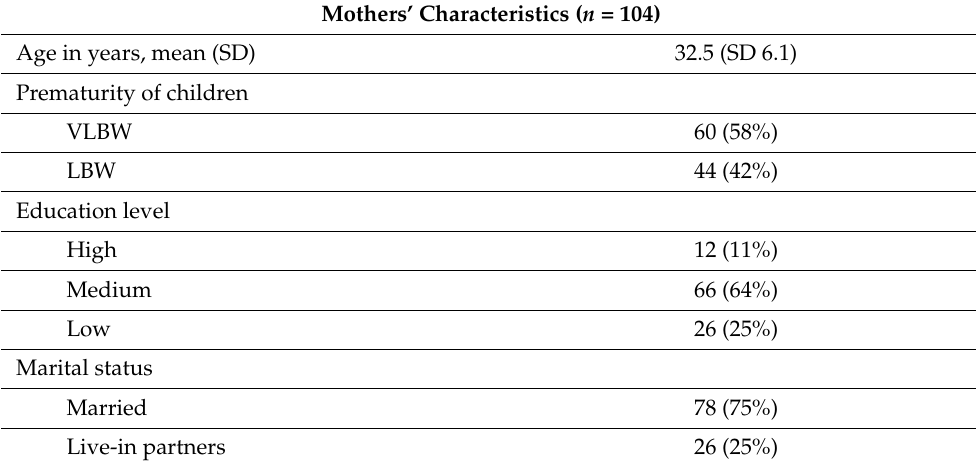
Table 1. Characteristics of the sample ( n =